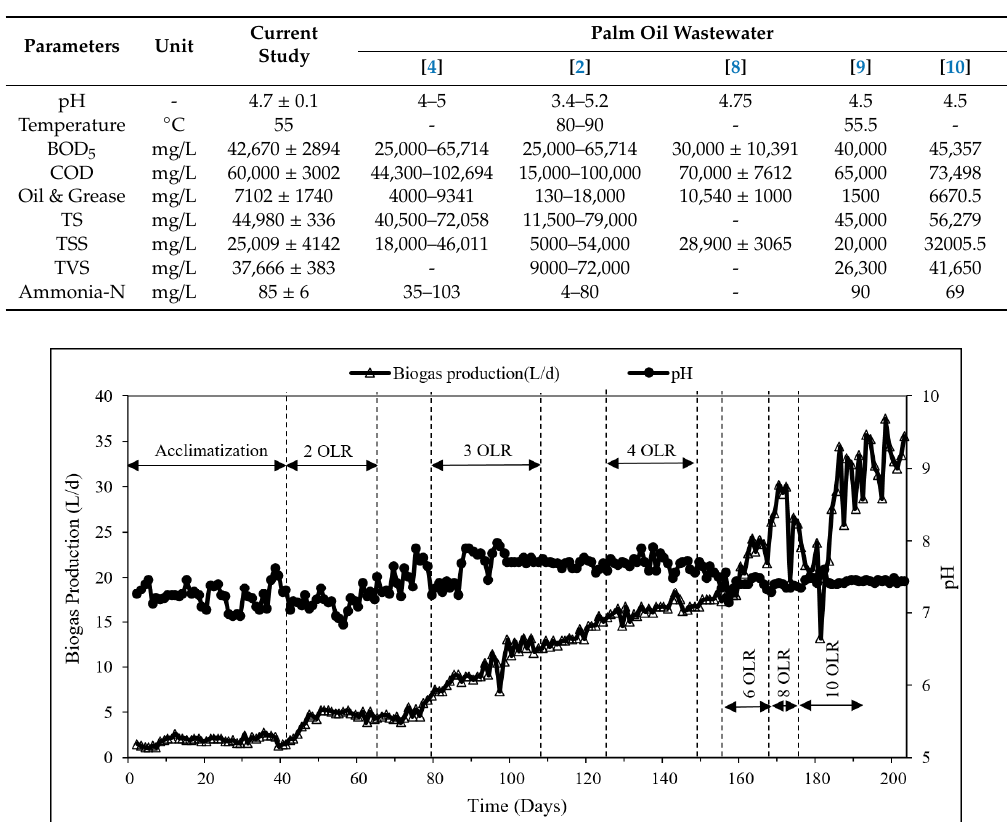
Table 1. Characteristics of the feed POME used in this study compared to previous studies.